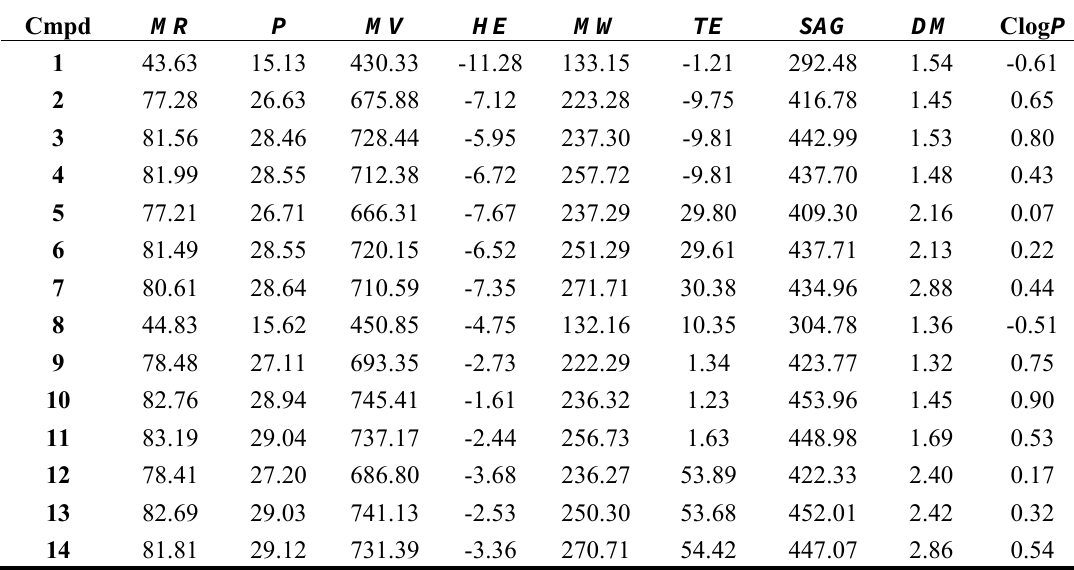
Table 3. Values of molecular descriptors used in the regression